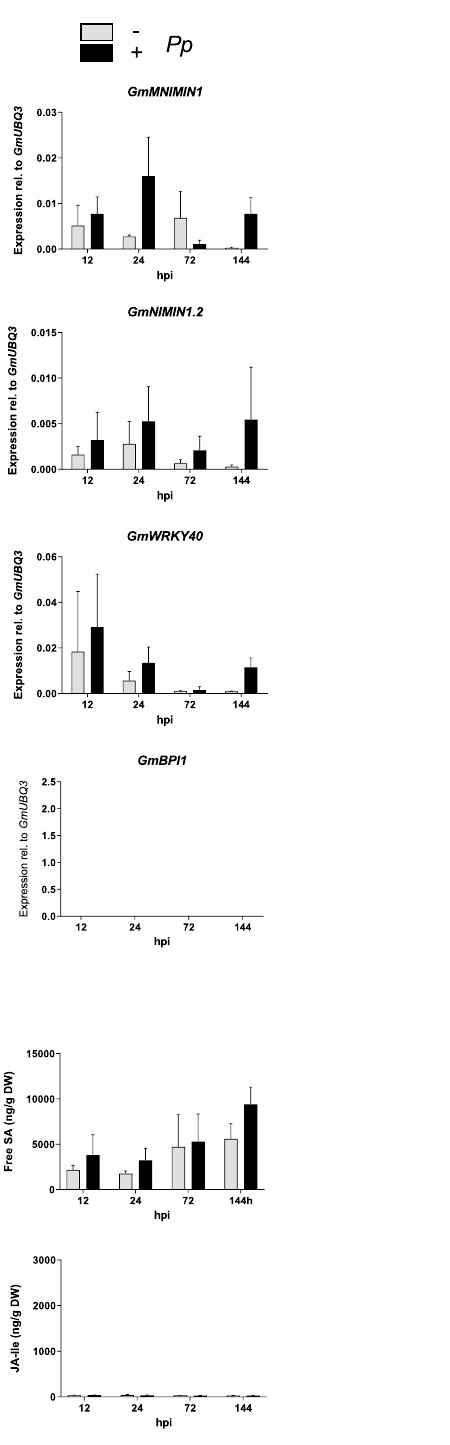
Figure 4. Correlation between the accumulation of free SA and JA-Ile and marker gene expression in soybean upon biotic stress. Expression of SA and JAs marker genes ( a ) and accumulation of SA and JA-Ile ( b ) in soybean leaves in a compatible interaction with Pp (left panel) or upon challenge with S. exigua larvae (right panel). To record hormonal and transcriptional responses upon challenge with Pp, first trifoliate leaves of intact soybean plants (W82, V2 stage) were either inoculated with a suspension of 1 mg ml −1 spores of Pp (isolate BR05) supplemented with 0.01% (v/v) Tween20 or treated with 0.01% (v/v) Tween20 only. To analyze the response of soybean plants to larvae feeding, first trifoliate leaves of W82 were subjected to 2nd–3rd instar larvae of S. exigua or left untreated (control). Hormone marker gene expression was quantified by qRT-PCR analysis and marker gene transcript abundance normalized to GmUBQ3 . Identical samples were used for determining mRNA levels and quantification of the levels of free SA and JA-Ile by LC–MS. Asterisks indicate significant differences to the respective control (Sidak’s multiple comparisons test; *p <